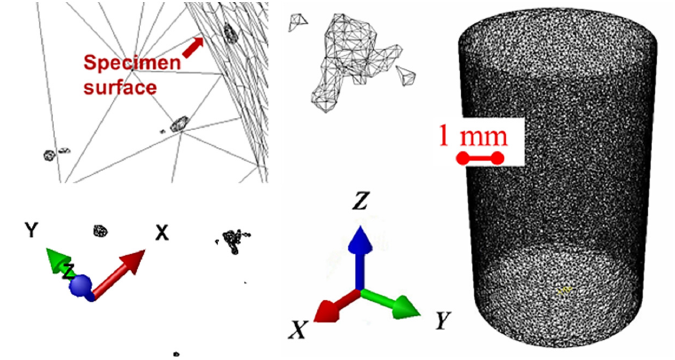
Figure 3. STL depiction of a µ-CT model.